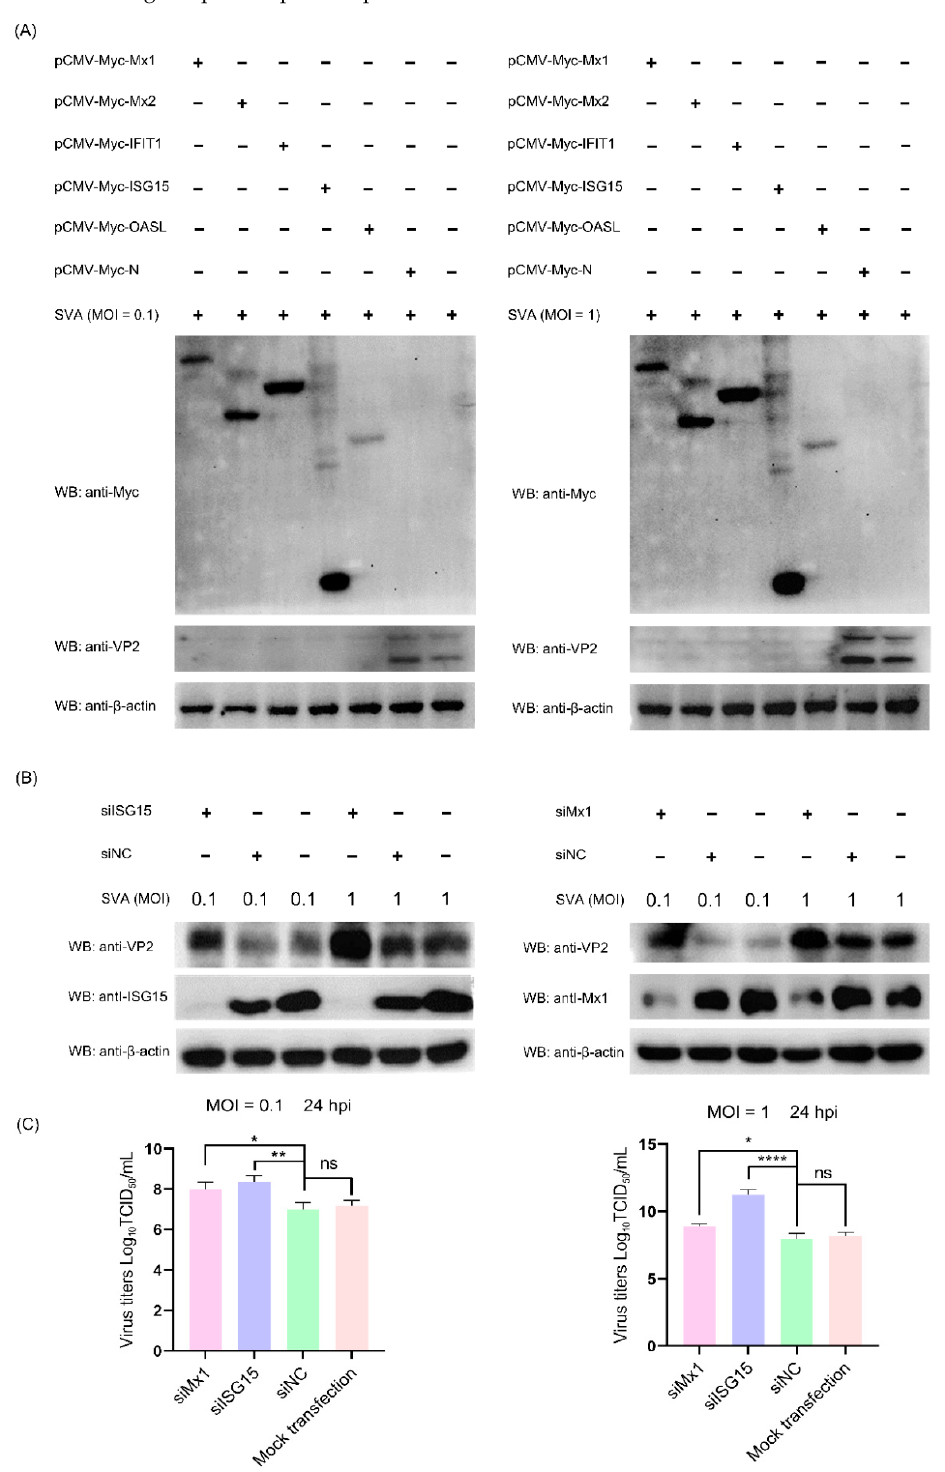
Figure 7. The interferon-stimulated gene (ISG) family proteins can efficiently inhibit the replication of SVA in PK-15 cells. ( A ) Overexpression of ISG proteins in PK-15 cells inhibits SVA replication. PK-15 cells were non-transfected or transfected with pCMV-Myc-Mx1, pCMV-Myc-Mx2, pCMV- Myc-IFIT1, pCMV-Myc-ISG15, pCMV-Myc-OASL or pCMV-Myc-N (empty vector). At 36 hpt, the transfected cells were infected with SVA at an MOI of 0.1 or 1. At 24 hpi, the cells were harvested and processed for WB analysis of VP2 protein expression. ( B , C ) Knockdown of ISG15 and Mx1 pro- teins in PK-15 cells promotes SVA replication. PK-15 cells were mock-transfected or transfected with